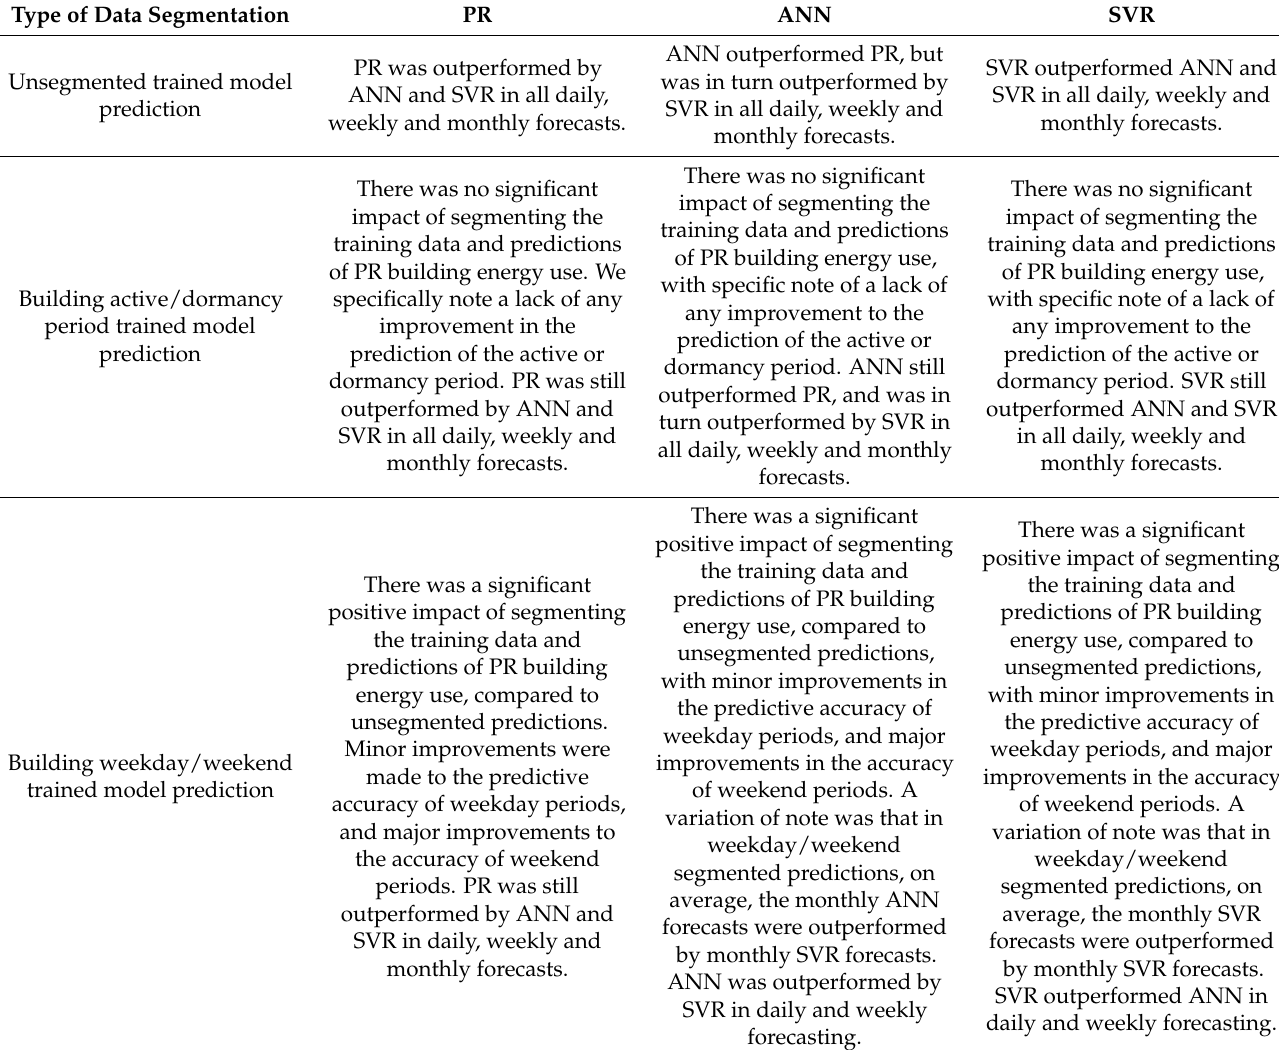
Table 2. The impact of segmenting training data on machine learning models in prediction of building energy usage. Type of Data Segmentation PR ANN SVR Unsegmented trained model